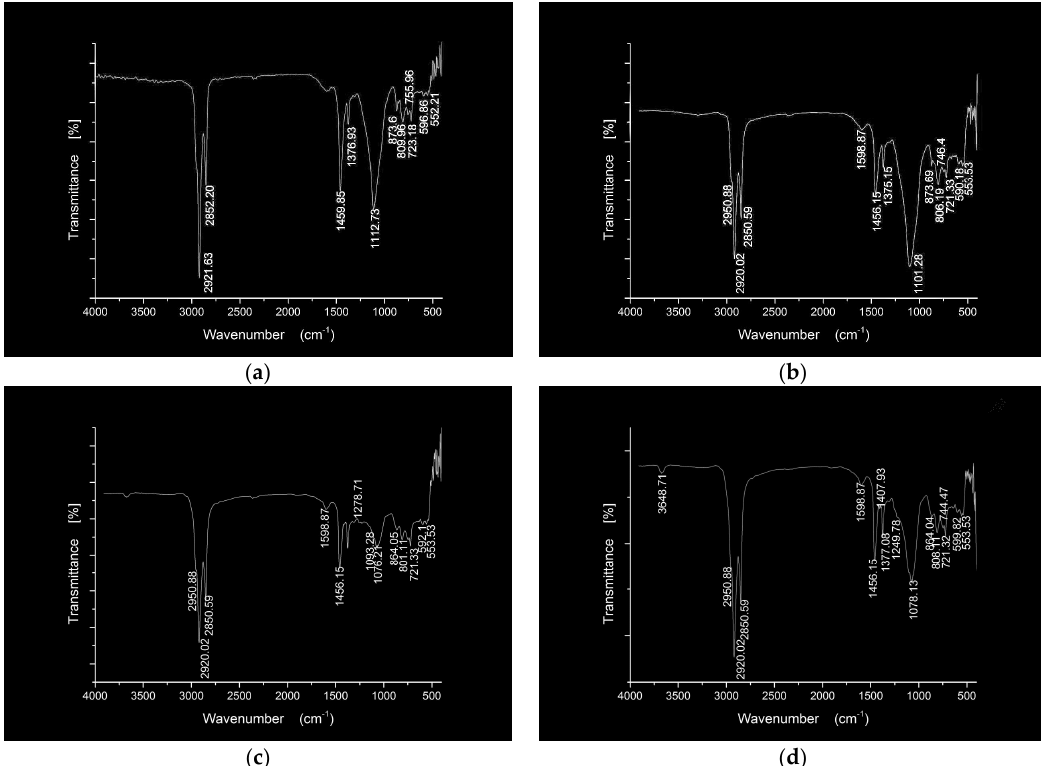
Figure 6. FTIR spectra of the SBA, OCSSBA, SOCSBA and SCASBA materials. ( a ) SBA; ( b ) OCSSBA; ( c ) SOCSBA; ( d ) SCASBA.